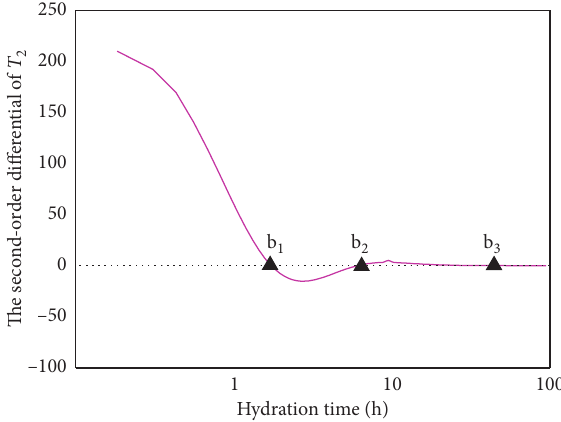
Figure 3: Second-order differential of A( t ).